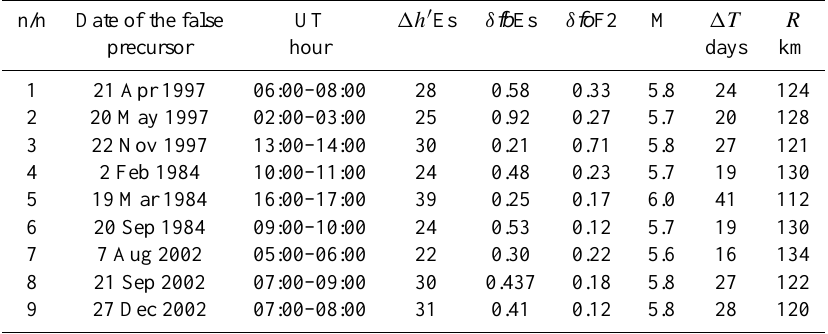
Table 4. Revealed false ionospheric precursors for three years 1997, 1984, 2002 along with calculated M, 1T , R values using the relation- ships (1–3). Only expected events with M ≥ 5.5 are